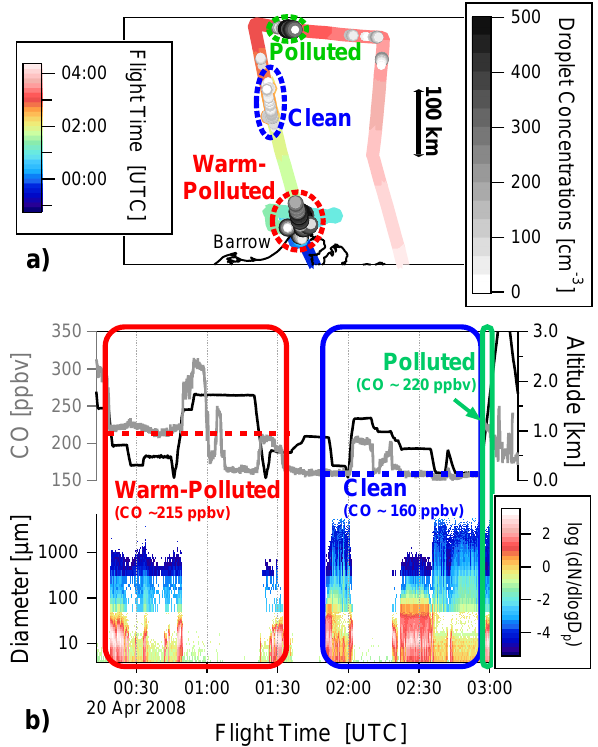
Fig. 1. (a) Flight track on 19 April 2008 colored by time, with cloud droplet concentrations marked in greyscale. (b) Timeseries of car- bon monoxide concentrations (top) and cloud particle size distri- butions (bottom) on the 19 April 2008 ARCPAC flight. The three cases as described in Sect. 2.3 are highlighed: warm-polluted clouds (red), clean clouds (blue), and polluted clouds